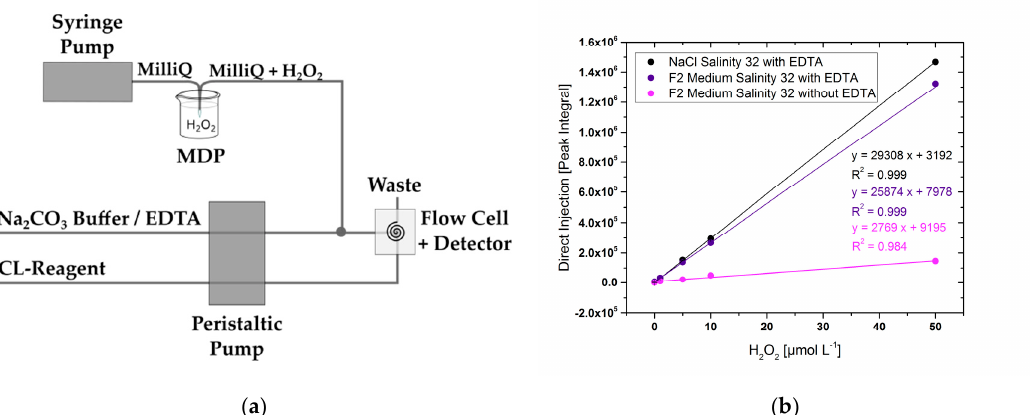
Figure 1. ( a ) Measuring set-up for H 2 O 2 measurements (modified from the original setup in Moßhammer et al. 2018 [2]) allowing the introduction of EDTA to the FIA system. The perfusion fluid is transported by the syringe pump through the microdialysis probe (MDP) were analytes such as H 2 O 2 can diffuse in. The enriched perfusion fluid is subsequently mixed with the EDTA in the carbonate buffer to remove interfering species and adjust the pH. Afterwards the solution is mixed with the acridinium ester resulting in chemiluminescence in the presence of H 2 O 2 . ( b ) The graph shows three calibration curves obtained by using the flow injection system without the MDP but by directly injecting the sample solution. Calibration curve without EDTA in the original set up [2] of the enriched seawater medium F2 (light purple, n = 1), a calibration curve of the F2 medium using the set-up shown in ( a ) in combination with EDTA (dark purple, n = 3), and the calibration curve in a NaCl-solution adjusted to the same salinity as the F2 medium (32) using EDTA (black, n =